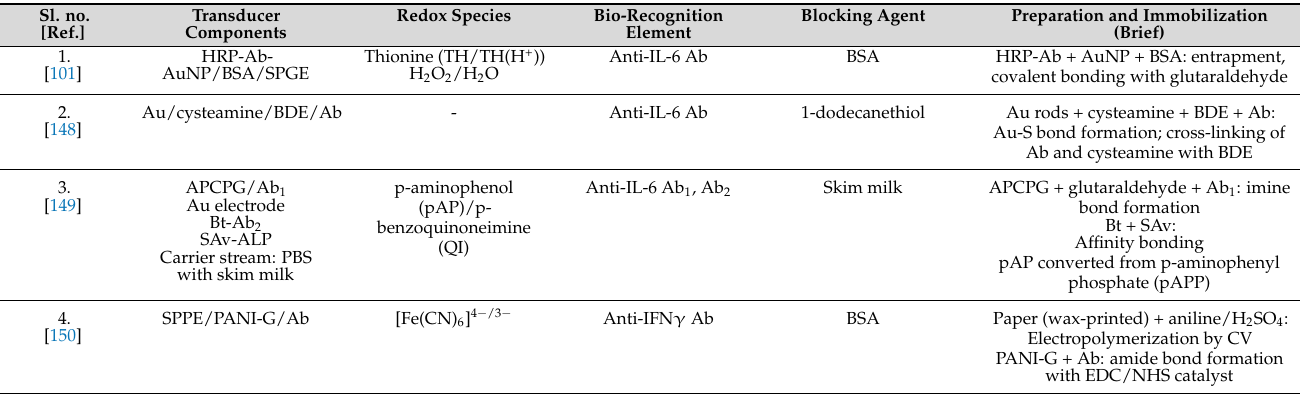
Common abbreviations: SPGE = Screen printed graphite electrode, BDE = 1,4-butanediol diglycidyl ether, APCPG = 3-aminopropyl- modified controlled-pore glass, SPPE = Screen printed paper electrode, PANI = polyaniline, G = graphene; Ab 1 = capture antibody, Ab 2 = signal antibody; EDC = 1-ethyl-3-(3-dimethylaminopropyl)carbodiimide, NHS =